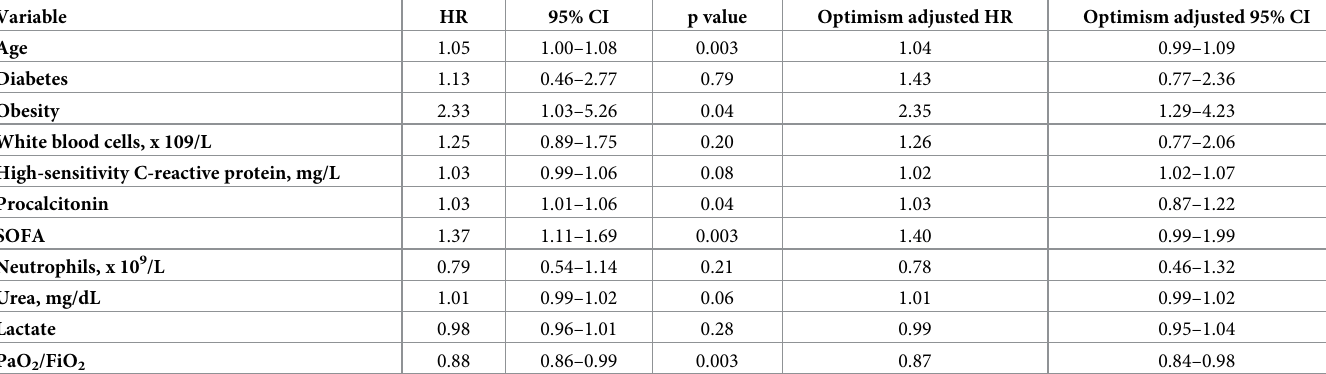
Table 4. Multivariable Cox proportional hazards regression analysis of factors associated with